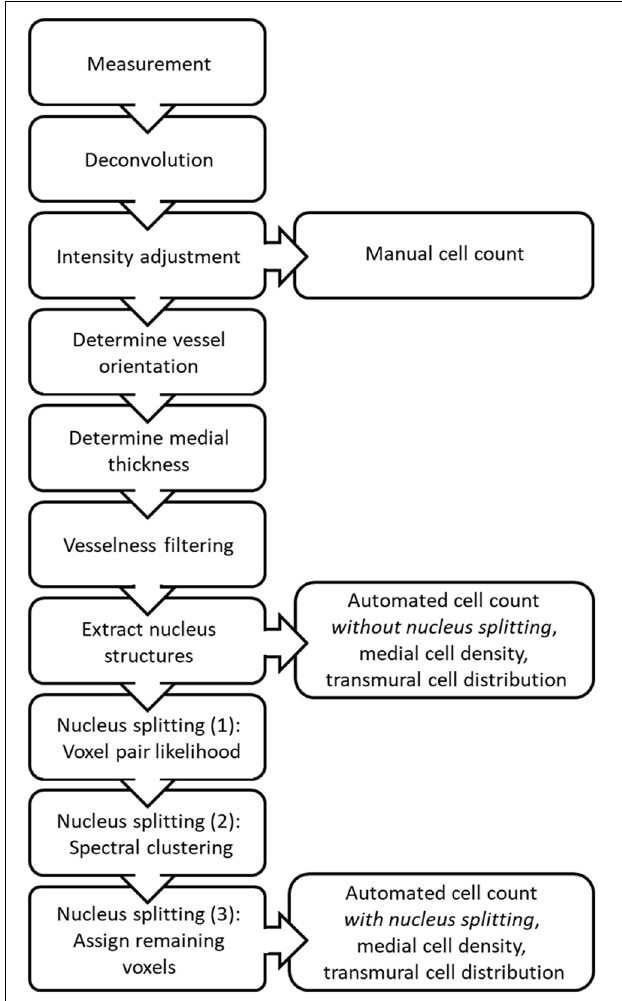
FIGURE 2 | Schematic overview of the steps taken during image stack analysis to produce the manual and automated counts, medial cell densities and transmural cell distributions, with and without nucleus